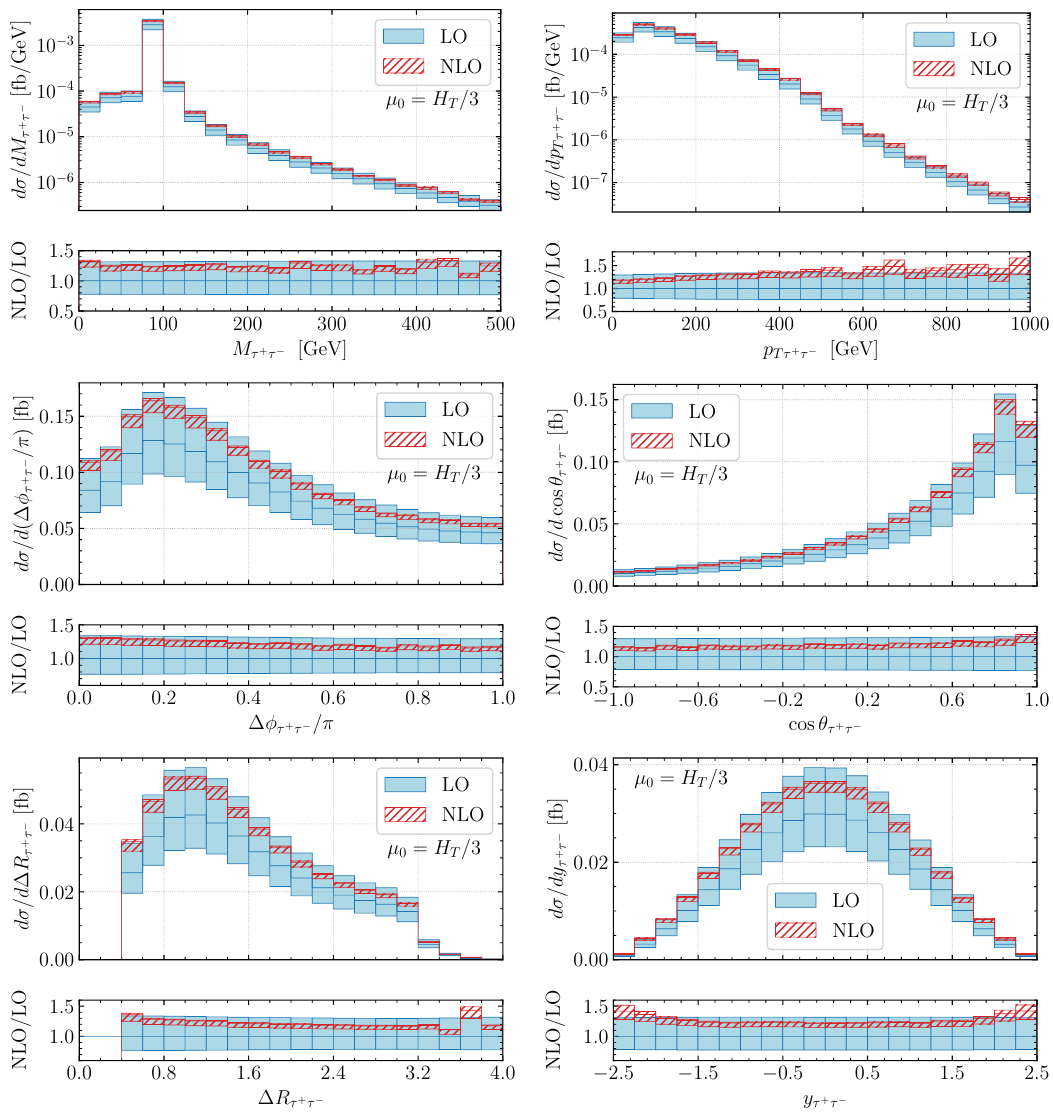
Figure 6 . Differential cross-section distributions for pp → e + ν e µ − ¯ ν µ b ¯ b τ + τ − + X at the LHC with √ s = 13 TeV as a function of M curve corresponds to the LO and the red curve to the NLO result. Also shown are the corresponding uncertainty bands resulting from scale variations. The lower panels display the differential K -factor together with the uncertainty band and the relative scale uncertainties of the LO cross section. The scale choice is µ R = µ F = µ 0 = H T / 3 . The cross sections are evaluated with the NNPDF3.1 PDF